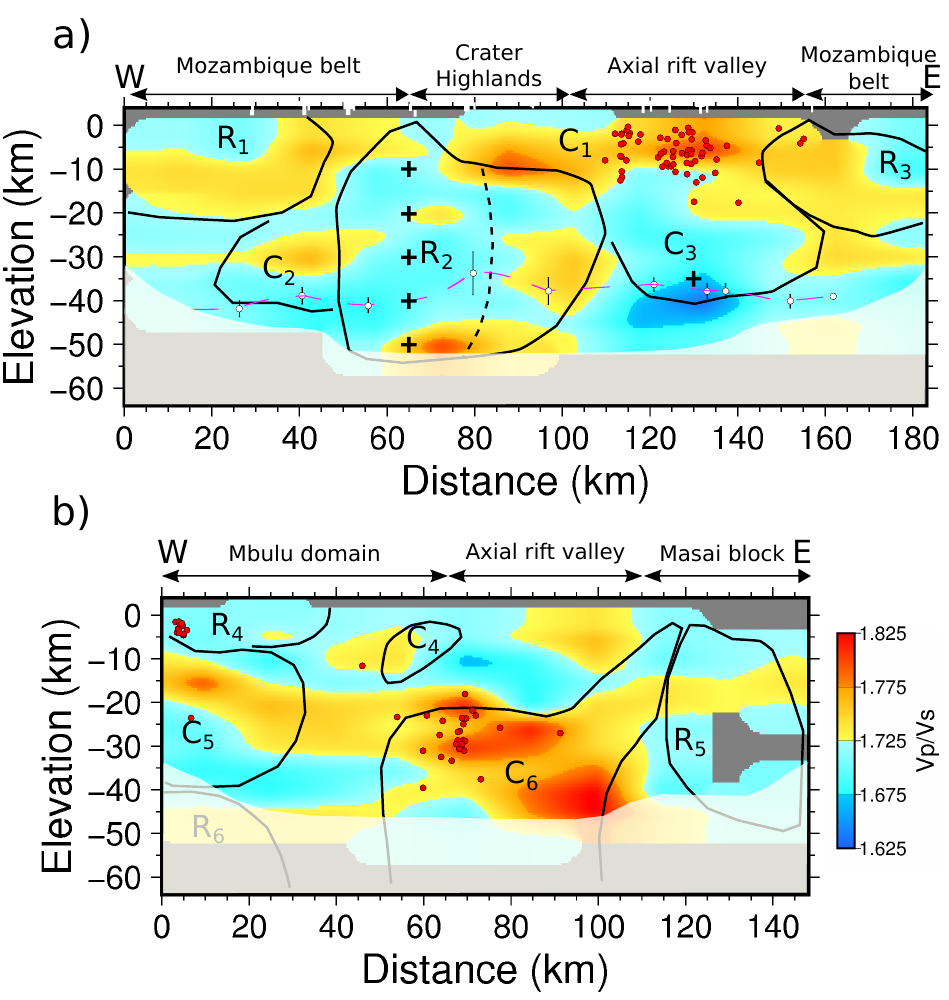
Figure 4. Vp/Vs ratio vertical sections of the tomography model [15] along the two MT profiles (Natron on the ( a ) and Manyara on the ( b )). Letters corresponds to structures imaged in the resistivity models. Black lines represent the limits of these structures. The pink dashed line and the white circles are the position of the Moho from Plasman et al. [35], only for the northern profile. The red dots are the earthquakes from Albaric et al. [14] relocated in a 3-D velocity model [15]. The white transparent mask delimits non resolved areas (deduced from Figures A10 and A11). Black crosses correspond to the location of spyke tests (see text for